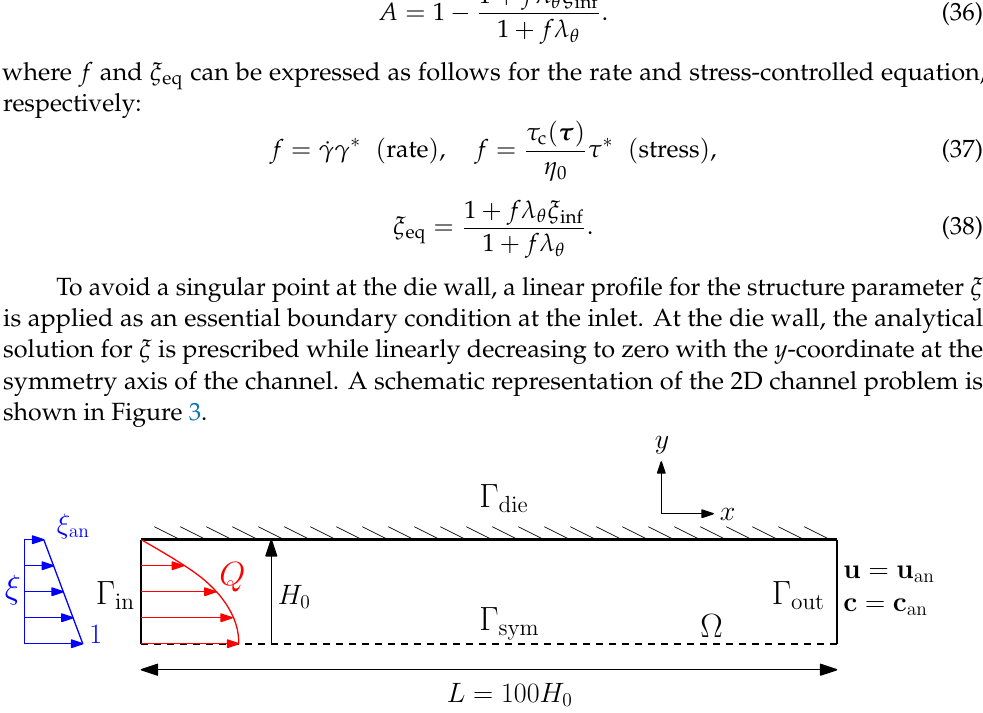
Figure 3. Schematic representation of the 2D channel problem used in the convergence study.